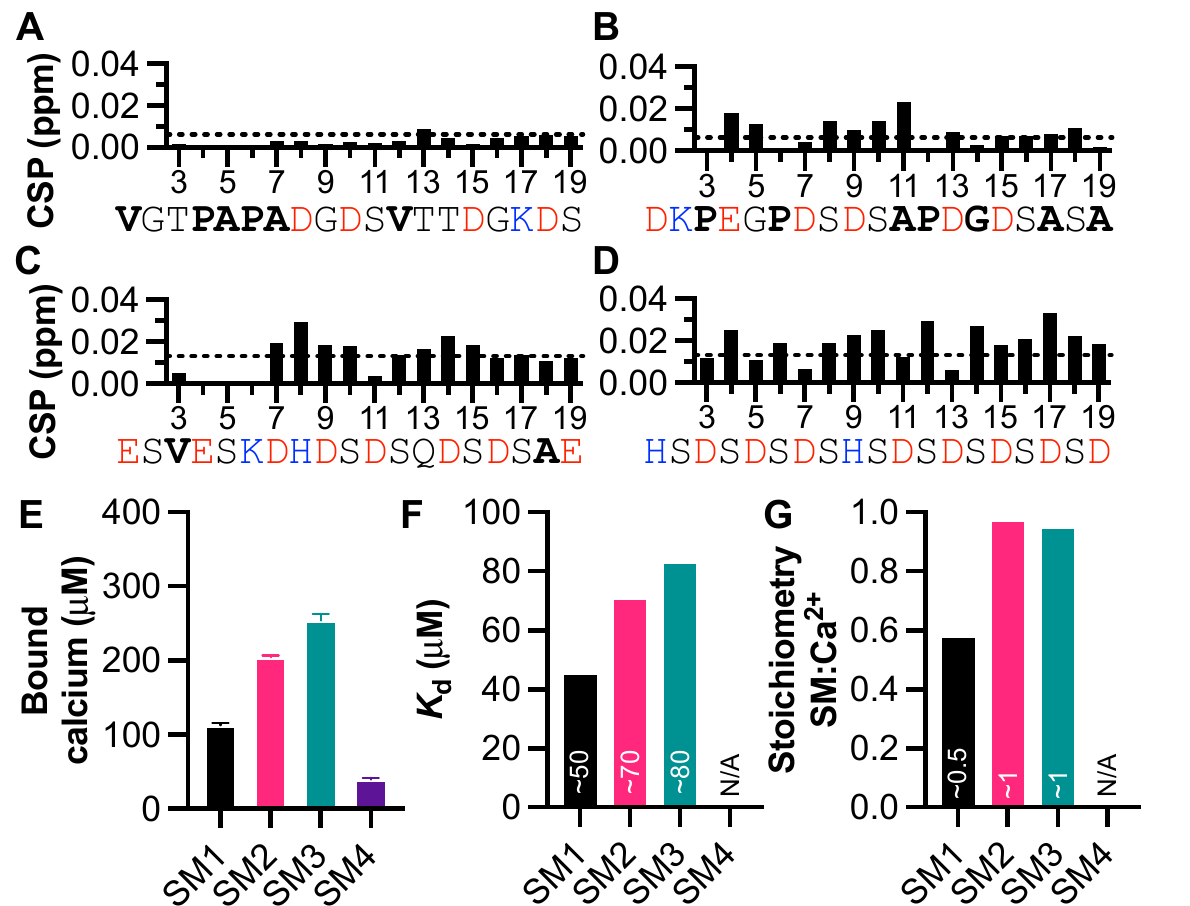
Figure 2. Narrowing down Ca-binding motifs using Starmaker peptides. ( A ) Amide CSPs caused by treatment of SM peptides with 1:1 CaCl 2 : ( A ) SM1, ( B ) SM2, ( C ) SM3, and ( D ) SM4. The dotted line indicates the threshold for CSP intensity, red indicates negative charge, blue indicates positive charge, and bold indicates hydrophobic residues. ( E ) Amount of calcium bound by each SM peptide (400 µ M), as measured using the OCPC assay. Error bars indicate SEM. ( F ) K d and ( G ) stoichiometry of the interaction between SM peptides and Ca 2+ calculated using Scatchard plots (Figure S3).